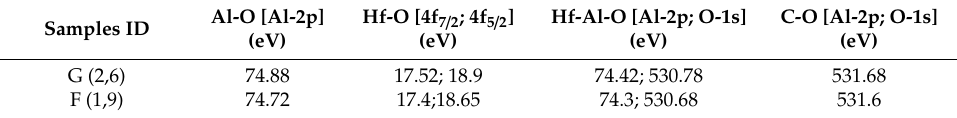
Table 2. The binding energies of di ff erent bonds according to peak position.